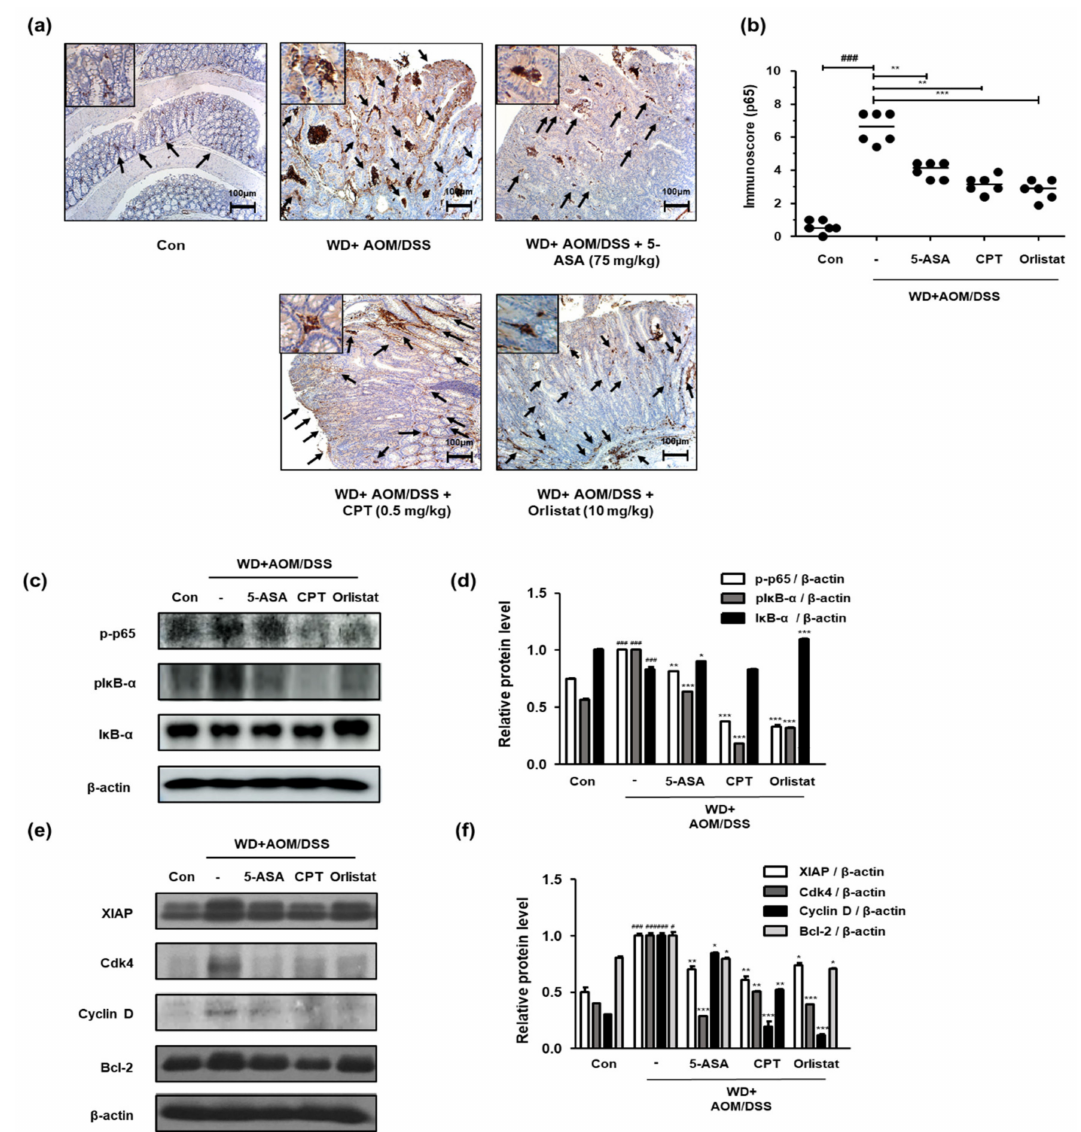
Figure 6. Effect of orlistat on NF- κ B p65 target protein levels in WD-driven CAC mice. ( a ) Immunoreactivity of NF- κ B p65; ( b ) estimated immunoscores for NF- κ B p65; ( c ) p-p65, I κ B, and pI κ B expression; ( d ) p-p65, I κ B, and pI κ B relative protein expression levels; ( e ) NF- κ B-related genes in colonic tissue were evaluated by western blot analysis; ( f ) XIAP, Cdk4, Cyclin D, and Bcl-2 relative protein levels. Relative protein expression levels were calculated by densitometric analysis and normalized to β -actin. # p < 0.05 and ### p < 0.001 when compared to Con; * p < 0.05, ** p < 0.01, and *** p < 0.001 when compared to WD +